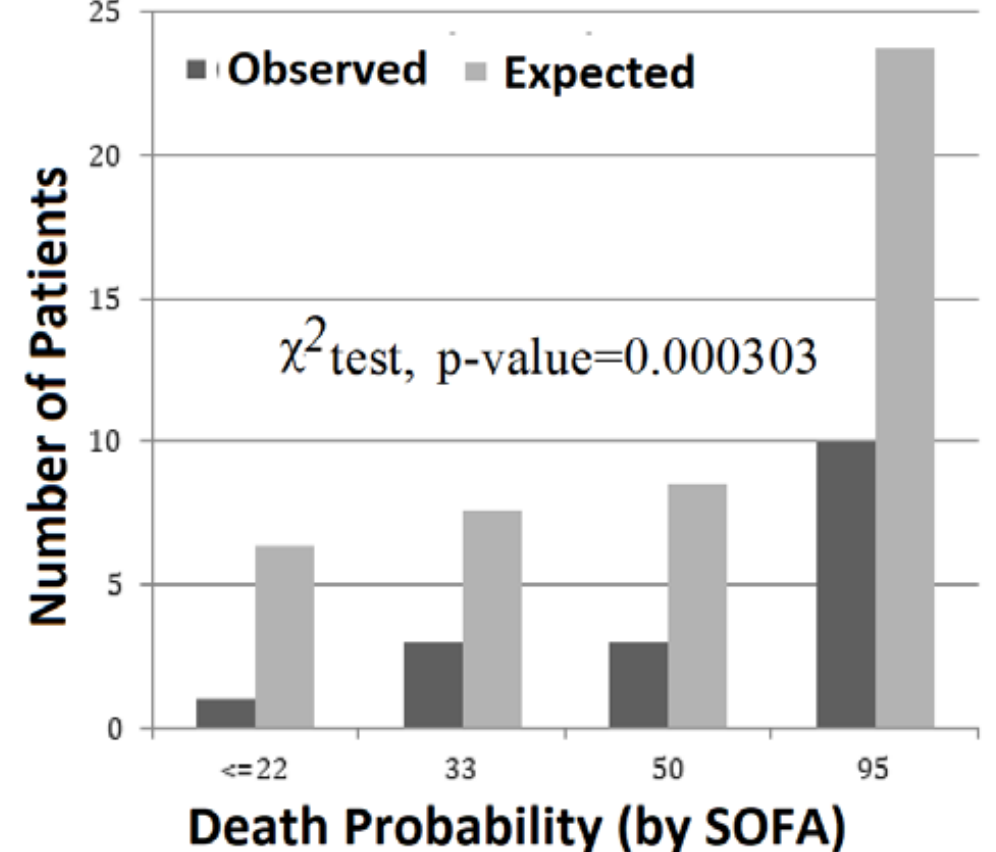
Figure 4. Comparison between the number of deaths in patients with severe malaria and the number of deaths expected/predicted by SOFA score.